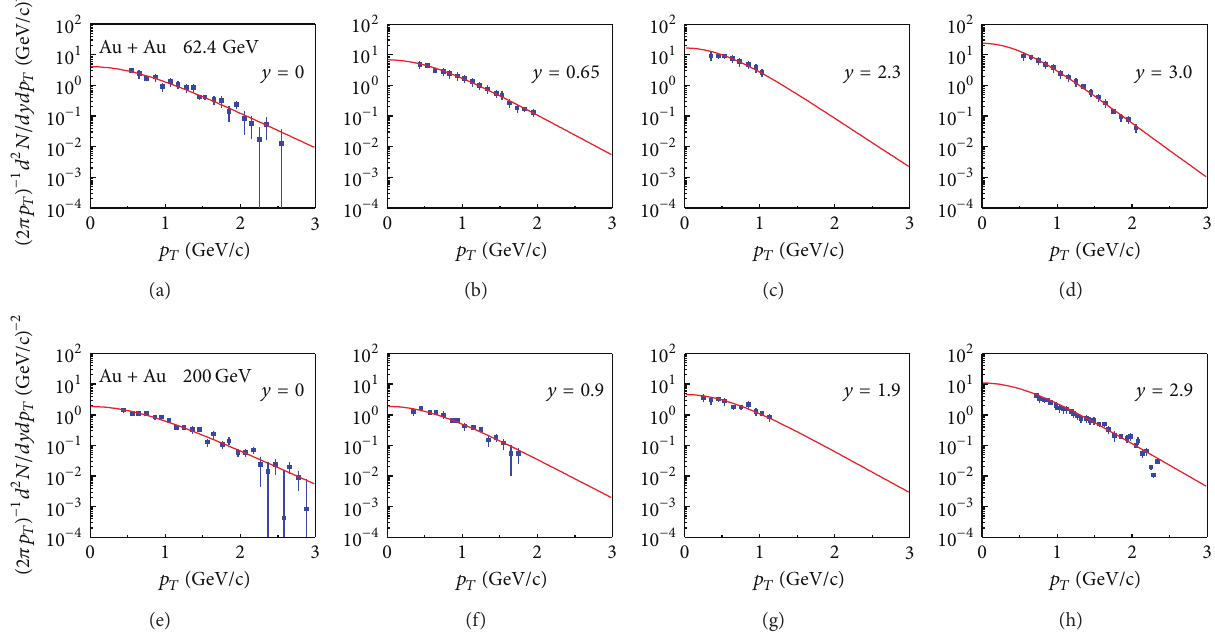
Figure 1: Transverse momentum distributions of net-baryons produced in central Au-Au collisions at different rapidities shown in the panels. (a)–(d) and (e)-(f) are for 62.4 and 200 GeV, respectively, where the symbols represent the experimental data of the BRAHMS Collaboration [17–19] measured at the RHIC and collected together in [20], and the curves are our modeling